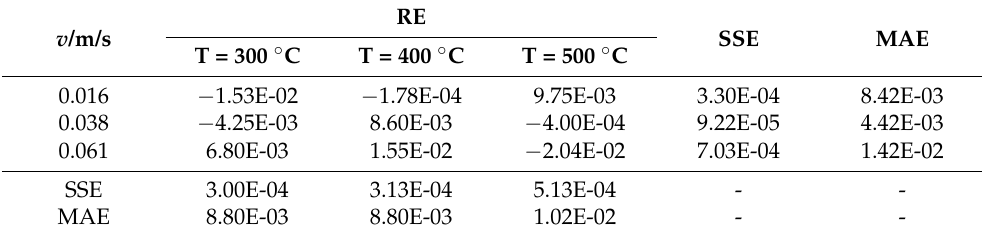
Table 8. The prediction model accuracy of the polynomial model. v /m/s